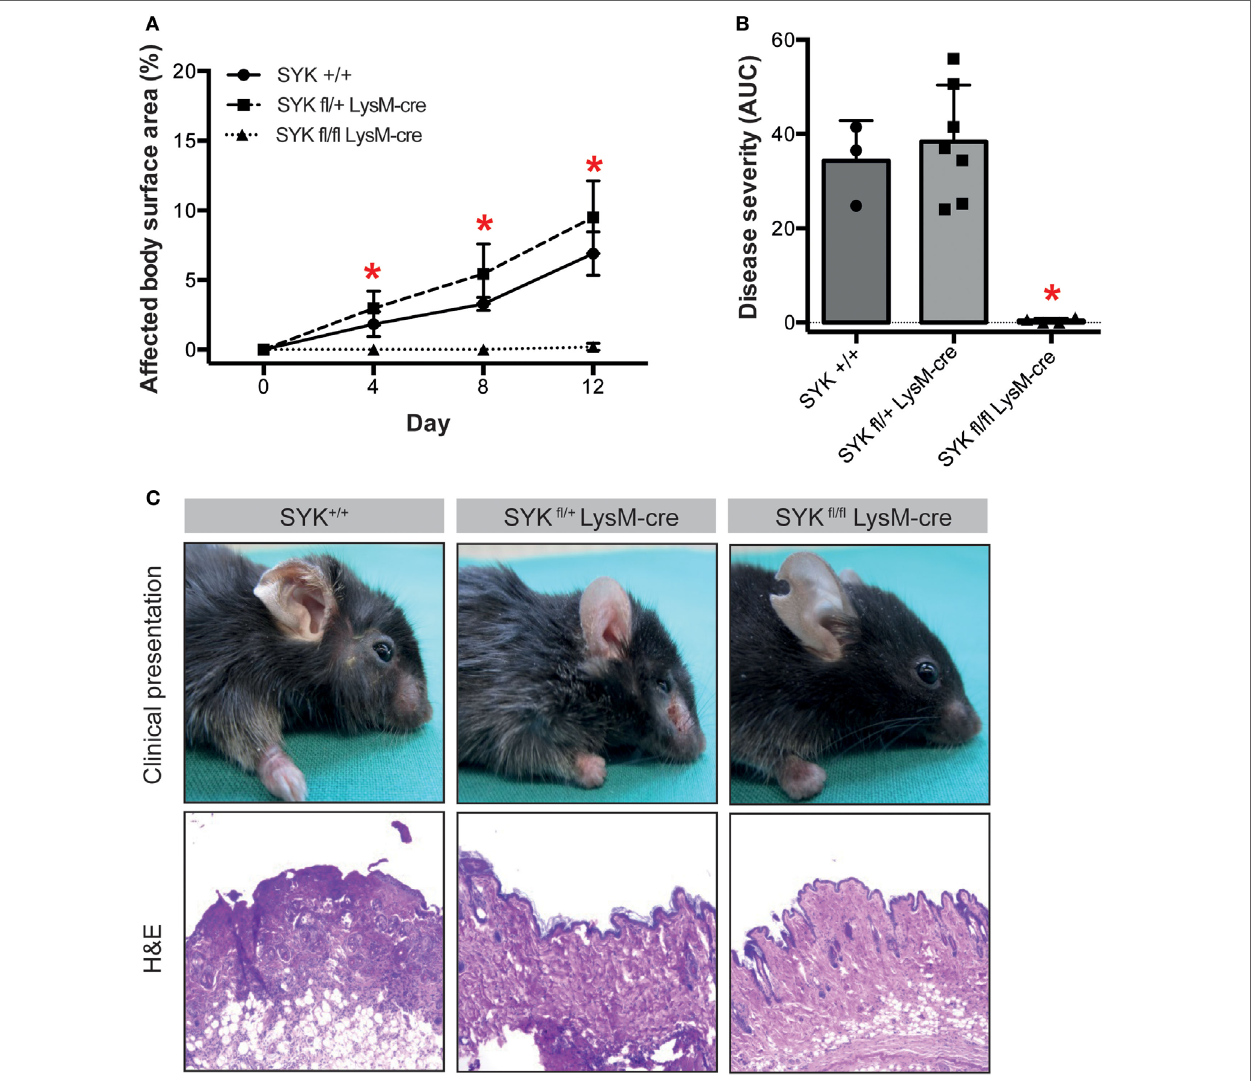
FigUre 4 | SYK fl/fl LysM-Cre mice are completely protected from induction of antibody transfer-induced epidermolysis bullosa acquisita (EBA). (a) Mean (SD) of affected body surface area after repetitive injections of anti-type VII collagen IgG into indicated mouse strains over the 12-day observation period ( n = 3–7/strain). SYK wild type ( + / + ) and mice with only one SYK allele in their myeloid cells (SYK fl/ + LysM-cre) developed clinically manifested skin lesions, whereas mice deficient for SYK in myeloid cells (SYK fl/fl LysM-cre) were completely protected from induction of EBA (* p < 0.05, ANOVA with Bonferroni post-test). (B) The cumulative disease severity [area under the curve (AUC)] confirms complete protection of the SYK fl/fl LysM-cre mice (* p < 0.05, ANOVA with a Bonferroni post-test). Individual dots correspond to the AUCs of single mice. (c) Representative clinical images and H&E-stained sections from the back skin of indicated mouse strains (100 × original magnification). All images shown are from day 12 of the